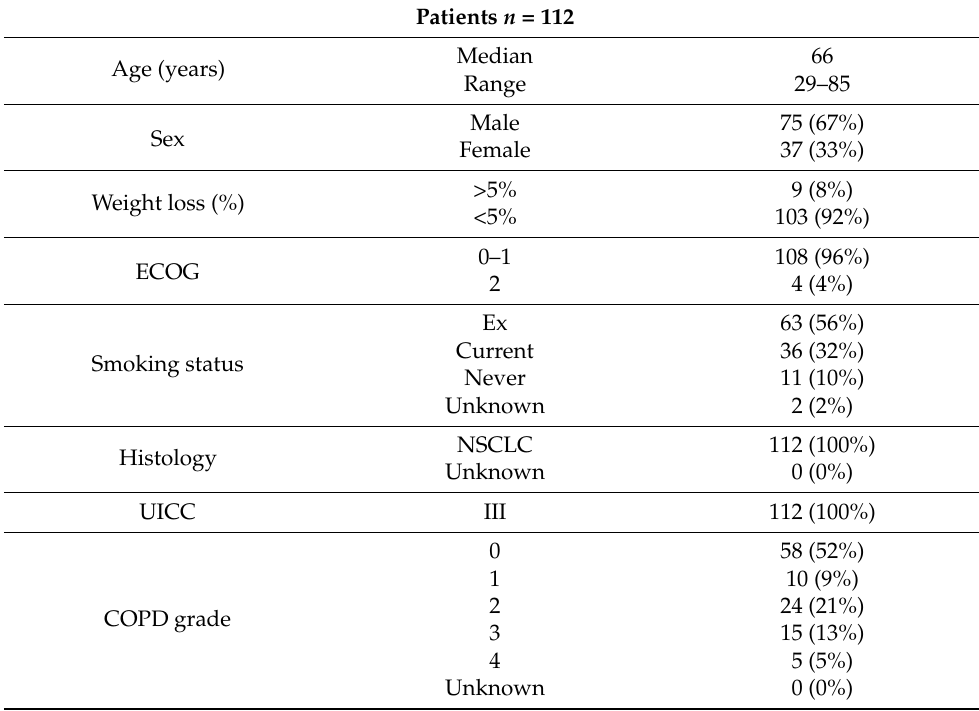
Table 1. Patient characteristics (NSCLC = non-small-cell lung